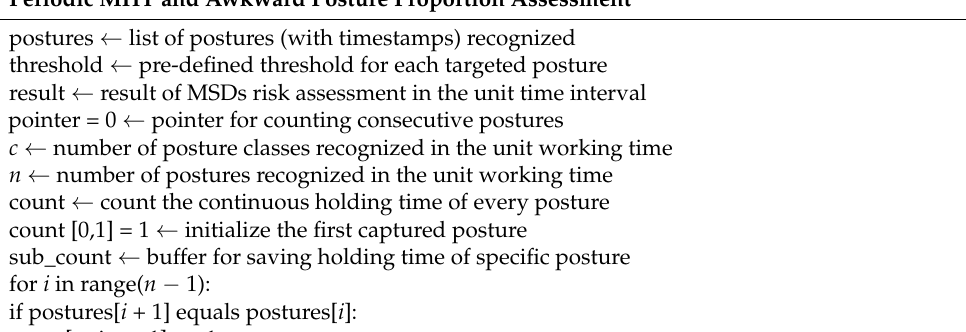
Table A3. Pseudo-code for periodical MHT and posture proportion